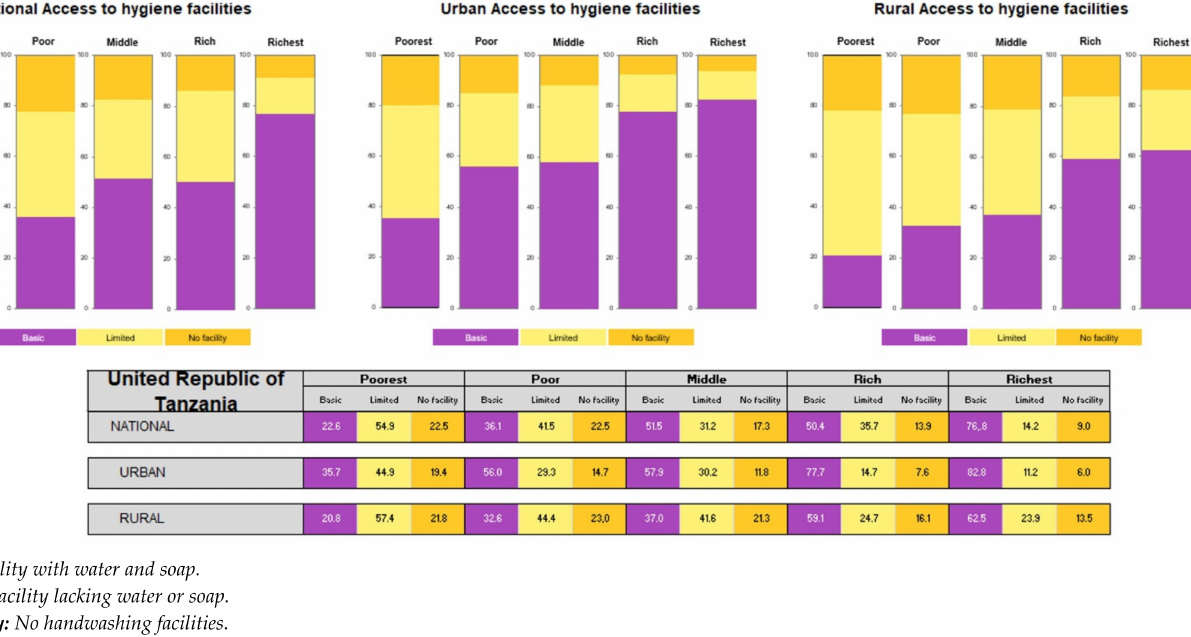
Figure 2. Summary of the trends in the use of hygiene facilities by wealth quintiles (%), United Republic of Tanzania, 2016. JMP metrics